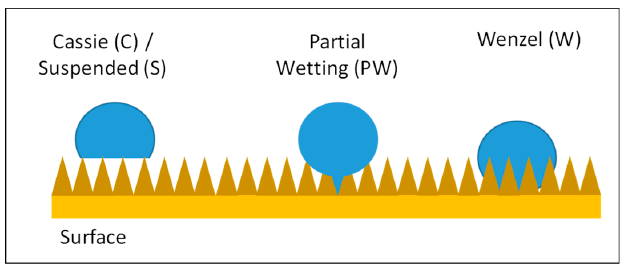
Figure 5. Young’s contact angle measurement.